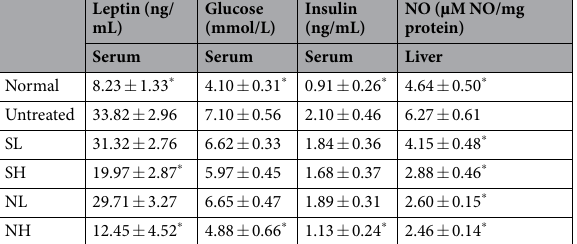
Table 1. Serum leptin, glucose insulin, and liver/fat pad NO levels of normal healthy, untreated, 0.08-ml/kg BW synthetic acetic acid vinegar (SL)-treated, 2-ml/kg BW synthetic acetic acid vinegar (SH)-treated, 0.08-ml/kg with * differed significantly compared to untreated groups (p < 0.05).